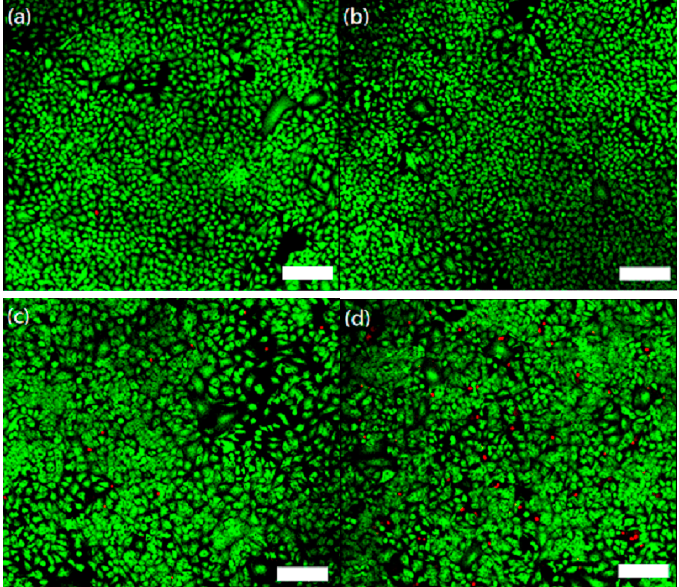
Figure 7. The PDT efficacy of CaCO 3 :Ce exposed to X-ray irradiation, evaluated by live/dead staining of ( a ) control group; ( b ) X-ray-treated group; ( c ) CaCO 3 :Ce group; and ( d ) PDT-CaCO 3 :Ce group, where living cells produced green fluorescence and dead cells showed red fluorescence (scale bars: 200 μ m).